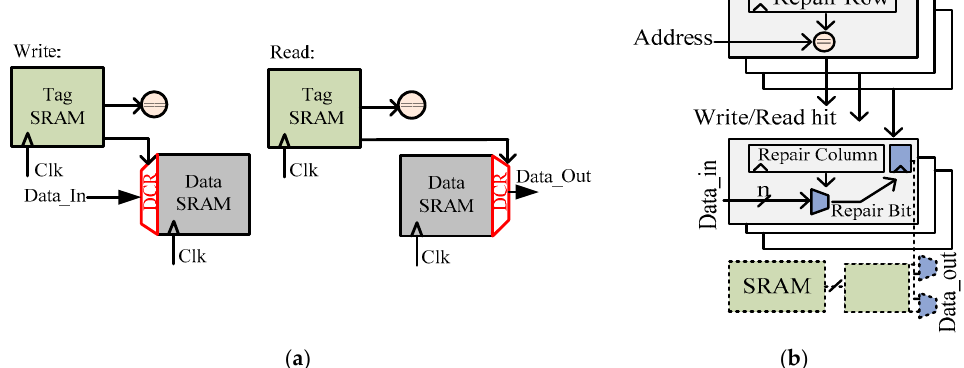
Figure 19. Flip-flop-based row redundancy architecture [57]. ( a ) Dynamic column redundancy (DCR); ( b ) bitline bypass (BB).